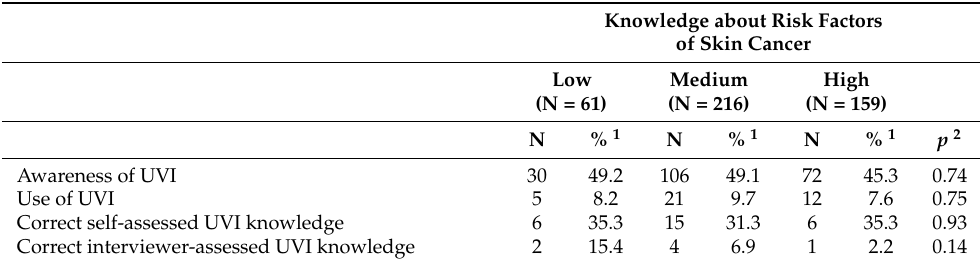
Table 4. The relationship between awareness, use and knowledge of the UVI and the level of knowledge about risk factors for skin cancer based on answers of directors of kindergartens (N = 436). Absolute frequencies (N), proportions (%) and p -values ( p ) assessing the association between UVI- related variables and knowledge of risk factors for skin cancer.